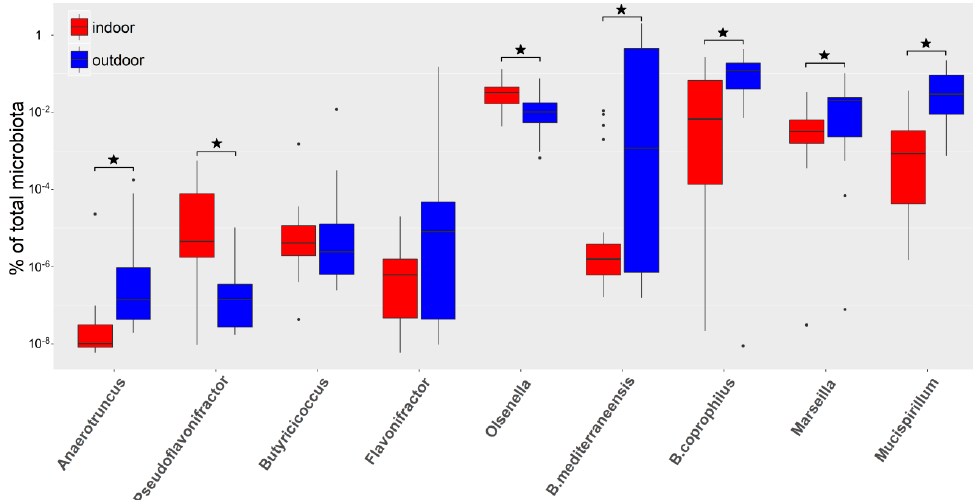
Figure 3. Real-time PCR quantification of selected species representing genera identified as differentially abundant in the microbiota of indoor (red boxes) and outdoor (blue boxes) chickens by 16S rRNA gene sequencing. * significantly different by Mann–Whitney test, p < 0.05.